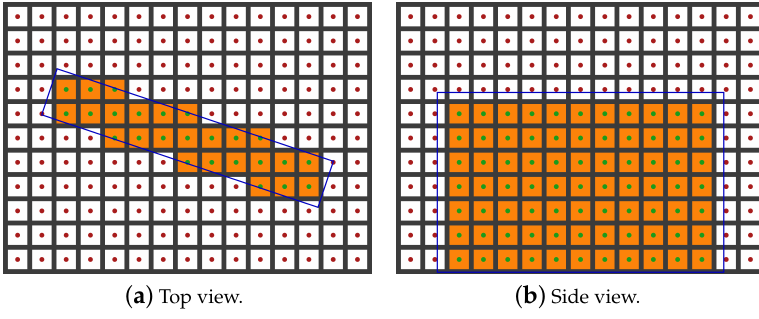
Figure 4. Cells corresponding to the VG coloured in orange where the body forces are applied. VG dimensions are indicated by the blue line.